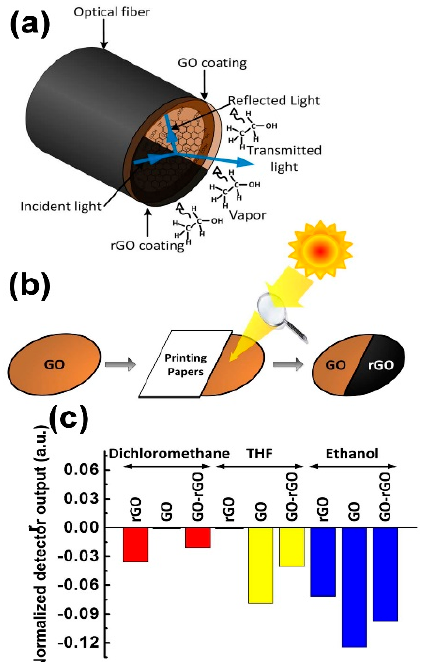
Figure 12. Schematic representation of the one-headed POF sensor covered with GO-rGO ( a ); Panel ( b ): fabrication process of the GO-rGO POF sensor by converting GO into rGO with sunlight; Panel ( c ): plot of the selectivity of one headed GO-rGO POF to THF, dichloromethane and ethanol. (Adapted with permission from Nature, Scientific Reports, London, United Kingdom, [86] copyright 2013).